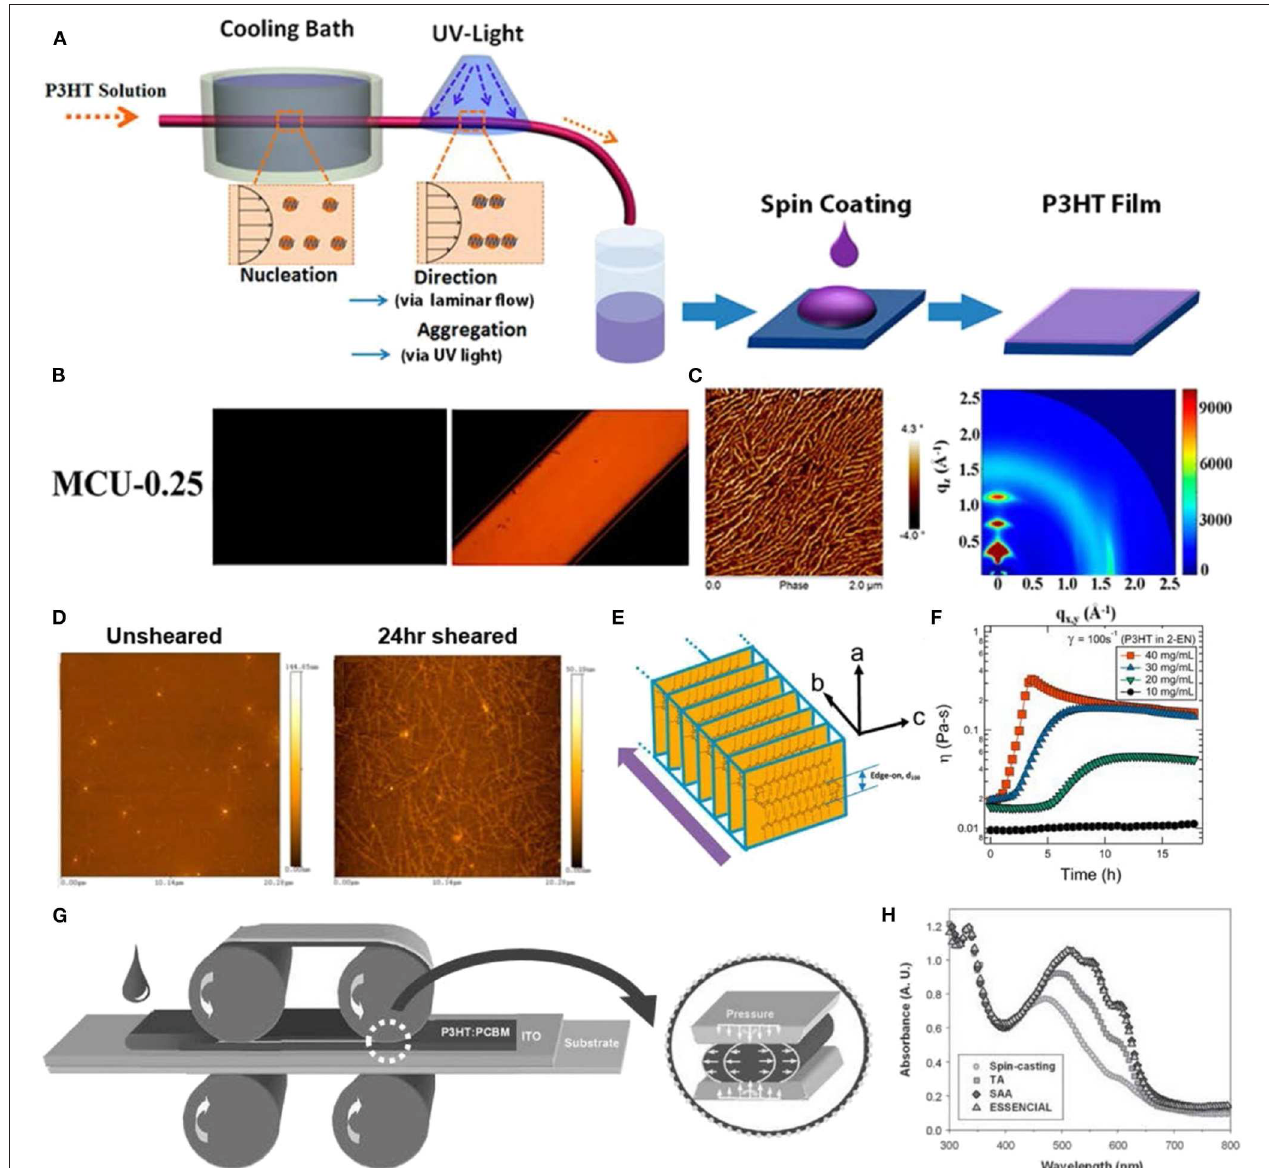
FIGURE 4 | Shear-induced polymer nucleation. (A) Schematic of microfluidics cooling-UV (MCU) method followed by spin coating. (B) Cross-polarized microscopy image of poly(3-hexylthiophene) (P3HT)/chloroform solution at the flowrate of 0.25 m/s. (C) Tapping-mode atomic force microscopy (AFM) phase image and grazing-incidence wide-angle X-ray scattering (GIWAXS) image of P3HT thin films on Si substrate at the optimum condition, MCU-0.25. (D) Tapping-mode AFM image of films spin coated from P3HT/2-ethylnaphthalene solution at 10 mg/ml under unsheared and 24h sheared conditions. (E) Schematic of molecular stacking in P3HT fibrils. The arrow indicates the fibril long axis. (F) Change in viscosity over time under a steady shear rate of P3HT solution at various concentrations. (G) Schematic of roll-to-roll coating with shear denoted as ESSENCIAL. (H) UV-visible spectra of thin film solar cell deposited from multiple methods. Figure reproduced with permission from Qu et al. [68] (and various references contained therein). Copyright 2016 by American Chemical